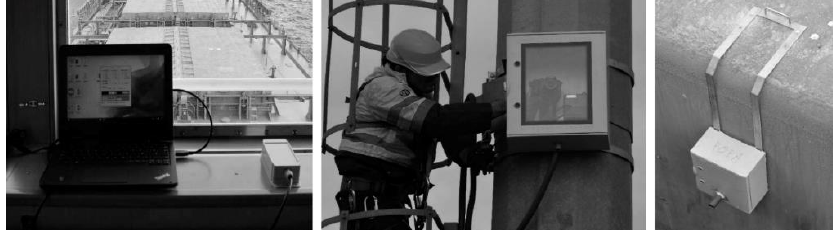
Figure 2. Left : IMU (Inertial measurement unit), Center : Photogrammetric techniques, Right : Laser distance sensor.